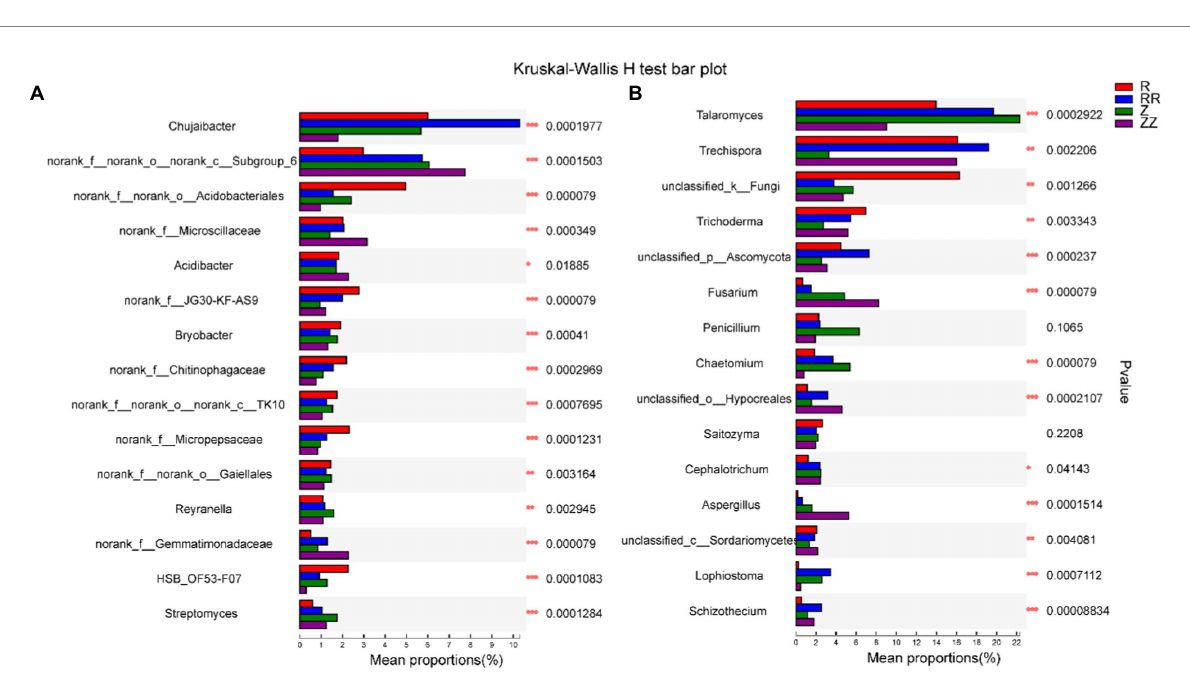
FIGURE 5 Effect of sugarcane straw returning on the different species analysis of top 15 soil bacterial (A) and fungal (B) on the genus level of different sugarcane cultivars. The differences between groups were calculated using the Kruskal-Wallis H test. ∗ p < 0.05; ∗∗ p <